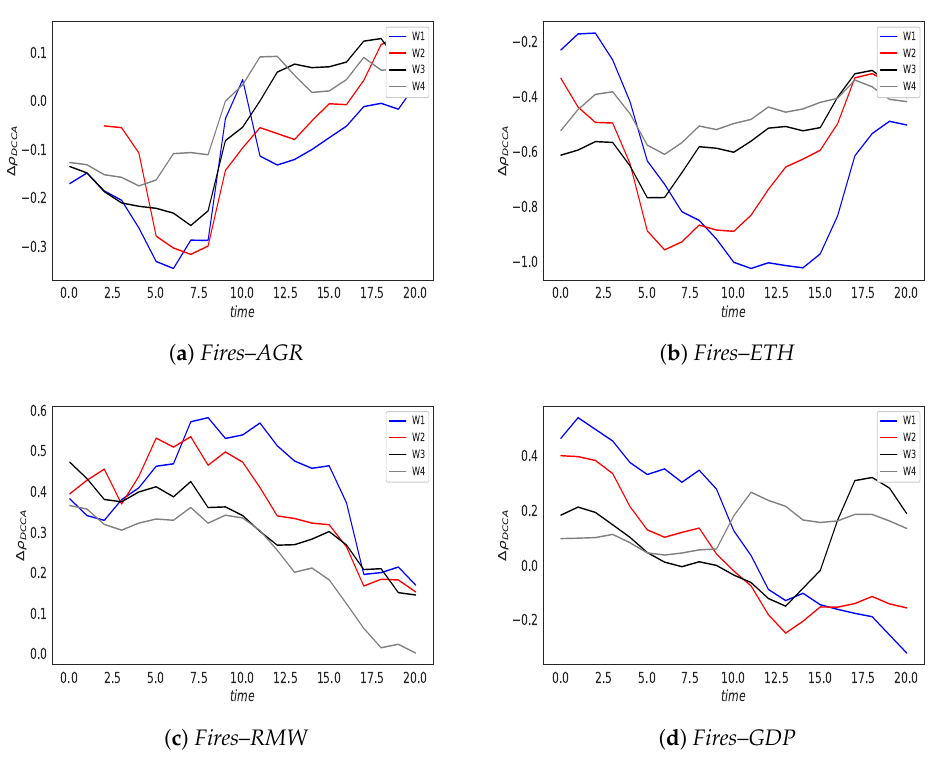
Figure A4. The ∆ ρ dcca for the different TS pairs and time scale n = 4.